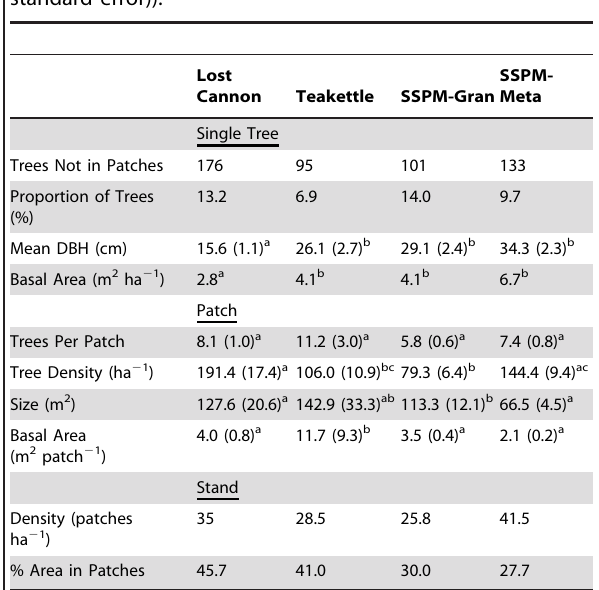
Table 3. Structural attributes of four old-growth Jeffrey pine- mixed conifer forests (patch values represent means (one standard error)).